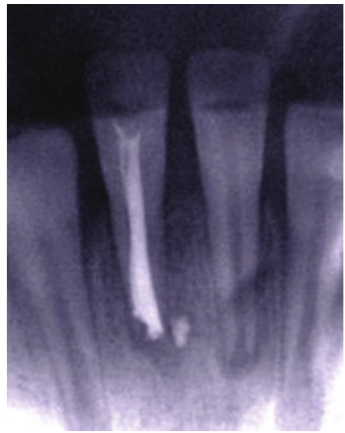
Figure 3: Two weeks after replantation, periapical radiolucency around the replanted tooth has increased considerably.